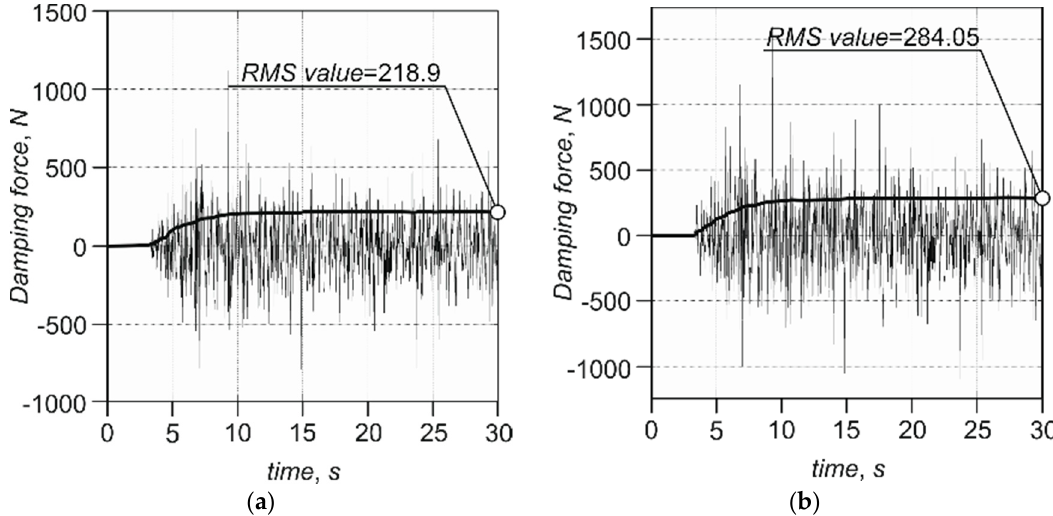
Figure 10. Damping force dependencies, over time, for road no. 3: ( a ) with permanent damping ( h SF 1 = 7500 Ns/m); ( b ) with the optimized damping law.